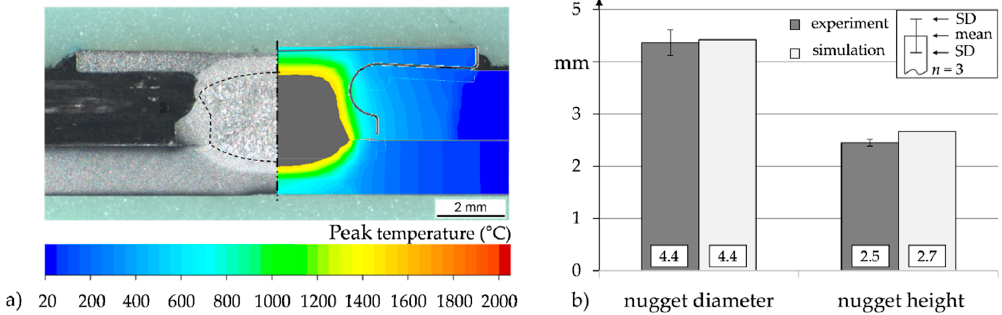
Figure 8. Validation of the welding simulation model via comparison: ( a ) of the shapes, ( b ) of the sizes of experimentally and simulatively generated weld nuggets.